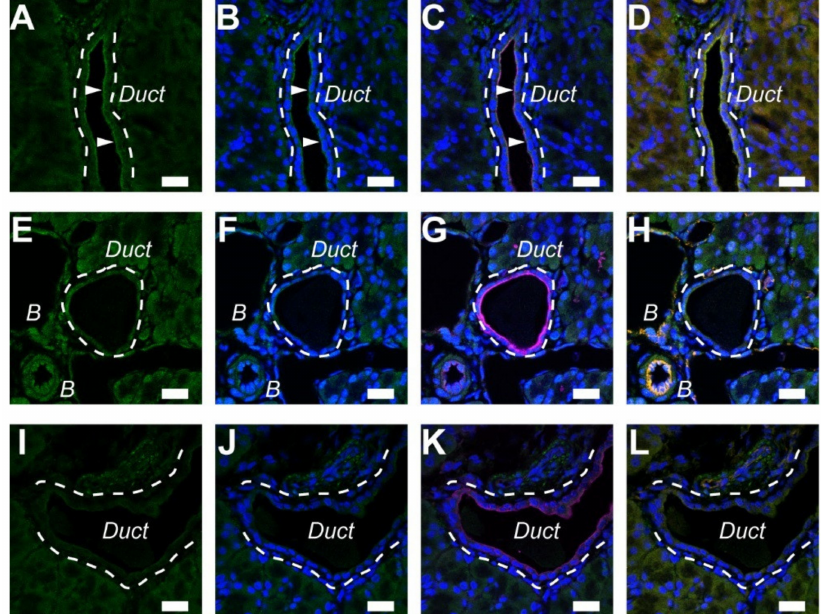
Figure 4. Immunolocalization of A 2A adenosine receptors in the pancreatic duct of the guinea pig. ( A ) Fluorescence of the A 2A adenosine receptor in the luminal membrane of duct cells (arrowheads). The broken lines indicate a duct. ( B ) Overlay of A and nuclear staining with DAPI (blue). ( C ) Overlay of B and fluorescence image of ezrin (purple). ( D ) Overlay of B and fluorescence image of a blood vessel marker (orange: PECAM-1) in the same sample. ( E ) The signal for the A 2B adenosine receptor was detected in the blood vessels (B). The broken line indicates a duct. ( F ) Overlay of E and nuclear staining. ( G ) Overlay of F and fluorescence image of ezrin (purple). ( H ) Overlay of F and fluorescence image of PECAM-1 (orange). ( I ) Isotype control image of the guinea pig pancreas with normal rabbit IgG (2 µ g / mL). ( J ) Overlay of I and nuclear staining. ( K ) Overlay of J and fluorescence image of ezrin (purple). ( L ) Overlay of J and fluorescence image of PECAM-1 (orange). Representative images of three guinea pigs are shown. Bars = 20 µ m.